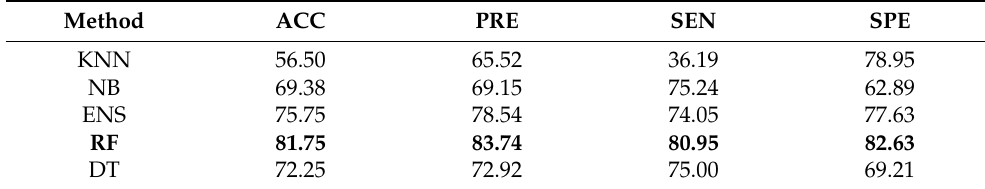
Table A2. AF detection performance based on CTW–RQA features ( n = 6).